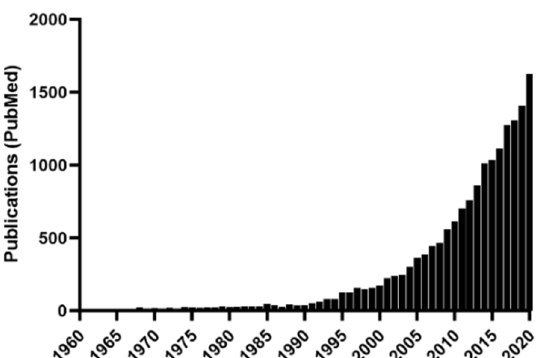
Figure 1. The number of articles retrieved by searching “mitochondrial diabetes” in the PubMed